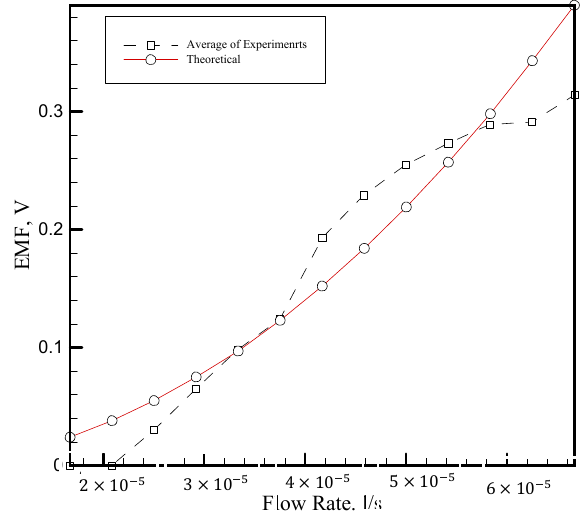
Flow Rate. l/s Figure 9. Graph of experimental vs. theoretical EMF Figure 9. Graph of experimental vs. theoretical EMF output.